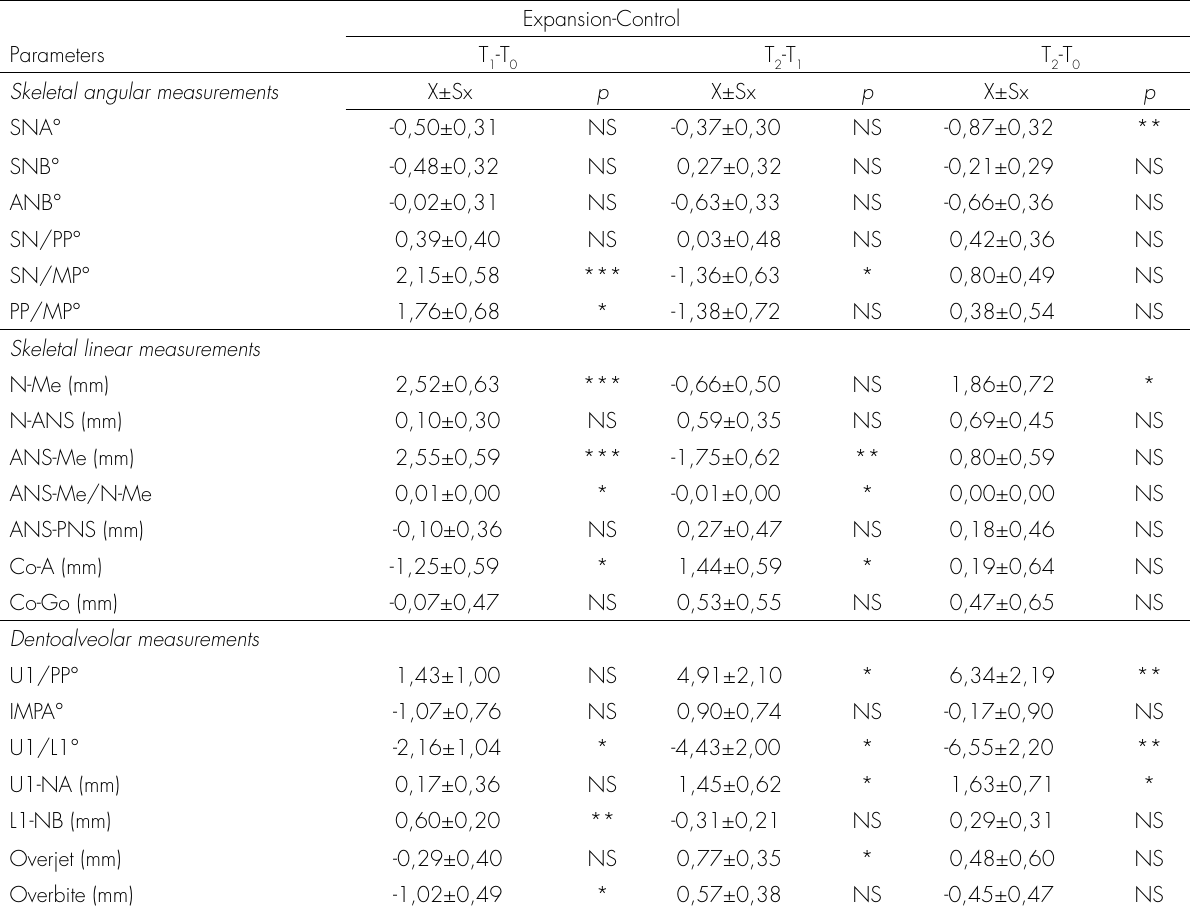
Table V. Mean differences in lateral radiographic measurements between the expansion and control groups during different